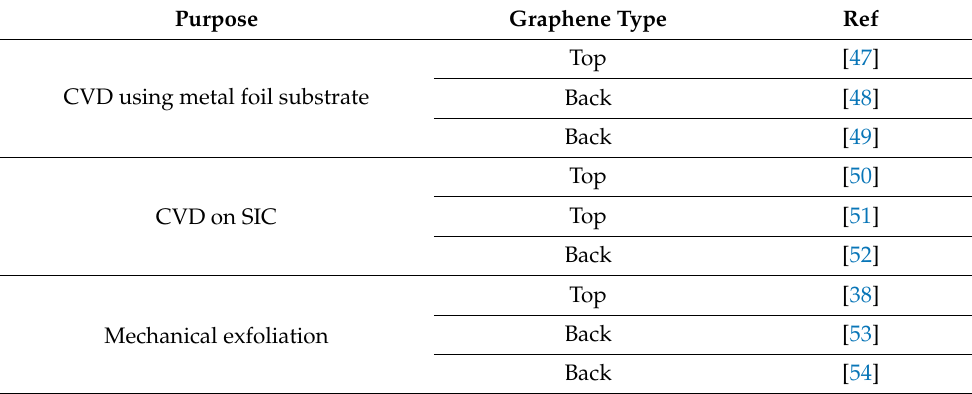
Table 4. Fabrication techniques used for graphene